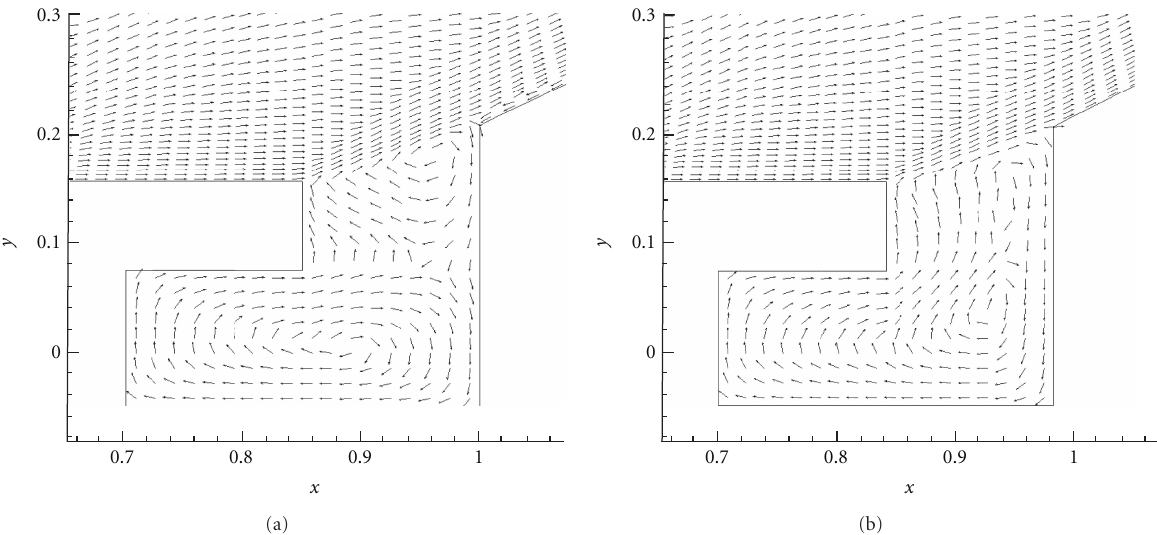
Figure 6: Velocity of the flow inside the cavity at two random time points.